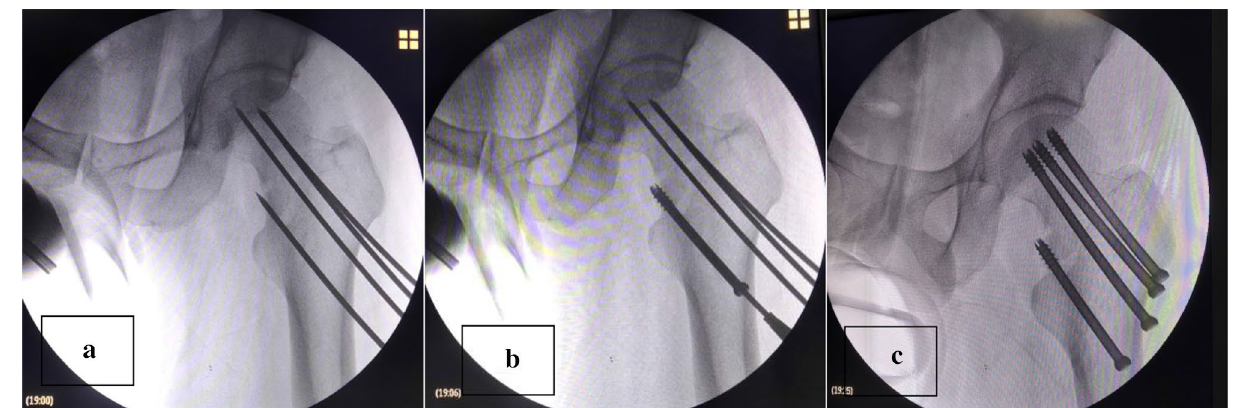
Figure 14. ( a ) The situation of percutaneous insertion of the guide needle after closed reduction during surgery. ( b ) The placement of the medial femoral neck brace. Due to the need to form positive support and resist shear forces, this screw is placed first. ( c ) is the placement of 3 cannulated screws and the medial femoral neck support screws to observe whether the placement of the screw is appropriate ( Note : The patient was a 47-year- old male. He was admitted to the hospital for 2 h due to a high fall